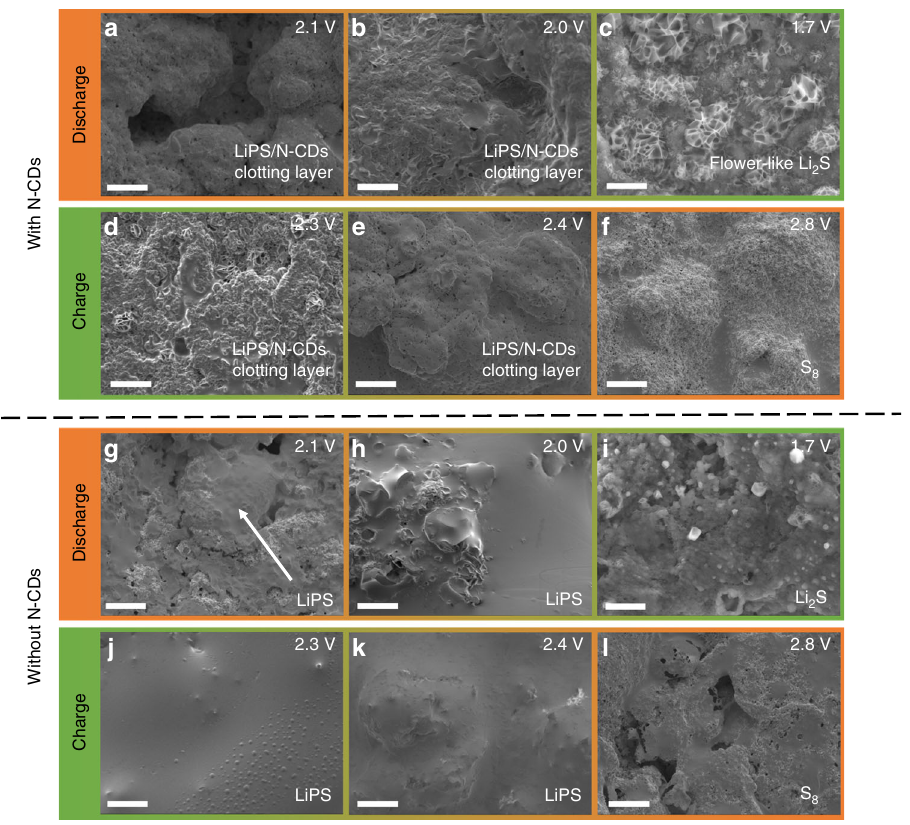
Fig. 5 Morphological change of the sulfur cathode surface in coin cells CR2032 loaded with 0 and 0.5 wt% N-CDs electrolyte during the fi rst discharge/charge process. a – f SEM images of the sulfur cathode with 0.5 wt% N-CDs electrolyte. g – l SEM images of the sulfur cathode with 0 wt% N- CDs electrolyte. Scale bar: 10 μ m.